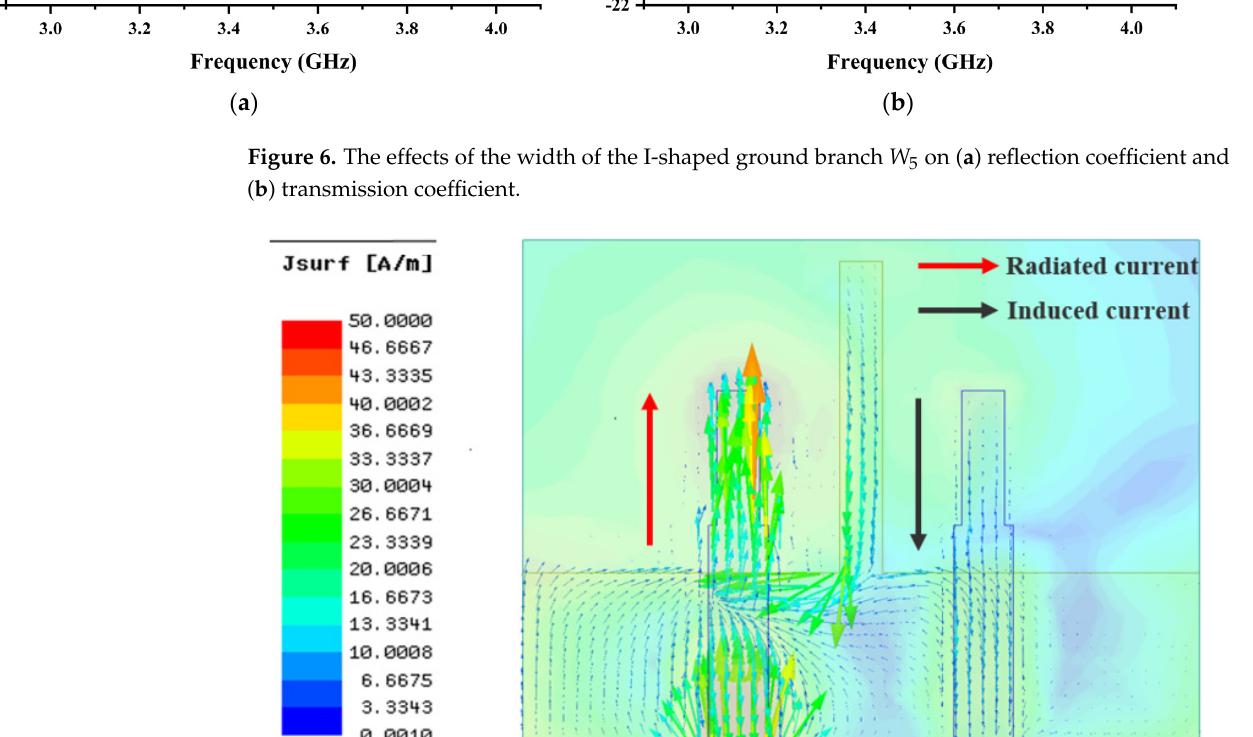
( b ) Figure 8. The distribution of the surface electric field of antenna 2: ( a ) top surface; ( b ) bottom surface. 2.5.3. The Decoupling Effect of the T-Shaped Ground Branch Despite the fact that the I-shaped ground branch can improve the isolation of the MIMO antenna, it is insufficient. With reference to the original antenna, only approxi- mately 5 dB isolation improvement is attained after the antenna is loaded with the I- shaped ground branch, which is mainly caused by the following two factors: (1) the inten- sity of the induced current on the surface of the ground stub is too weak and, thus, the field generated by the induced current cannot counteract the coupling field between an- tenna elements entirely; (2) the induced current is mainly concentrated along the x direc- tion and, thus, the field generated by the induced current cannot cancel out with the cou- pling field distributed along the y direction. Due to the above two factors, the intensity of the remaining coupling field between antenna elements is still too large. In other words, the amplitude of the coupling energy K 1 d is too low compared with K 12 . Consequently, to further reduce the mutual coupling between antenna elements, two crucial requirements associated with the induced current located on the decoupling structure should be satis- fied. One is that the intensity of the induced current should be in proximity to the coupling current. The other is that the distribution area of the induced current should be as large as possible to counteract the coupling current. To meet the above two requirements, a thin horizontal stub is added to the end of the ground stub to form a T-shaped ground branch in antenna 3, which effectively overcomes the deficiency of the ground stub where the induced current along the Y direction is totally lacked. At the same time, the introduction